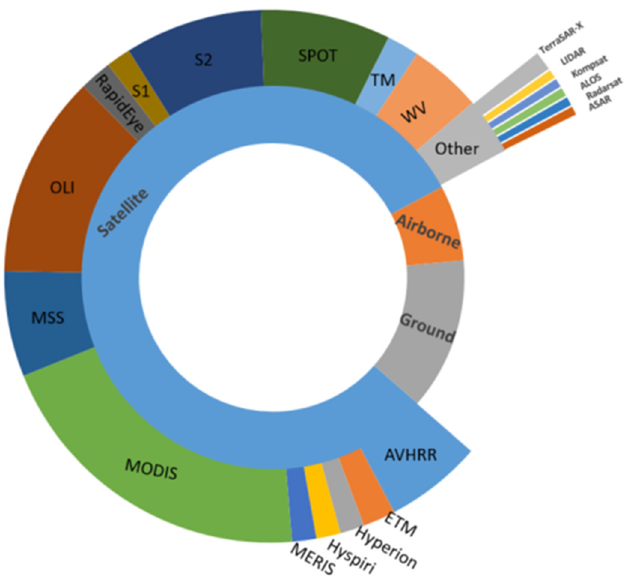
Figure 6. Popularly used remote-sensing sensors used in GP monitoring. WV = WorldView, S-1 = Sentinel-1, S-2 = Sentinel-2, OLI = Operational Land Imager, ETM = Enhanced Thematic Mapper, and MSS = Multi-Spectral Scanner.